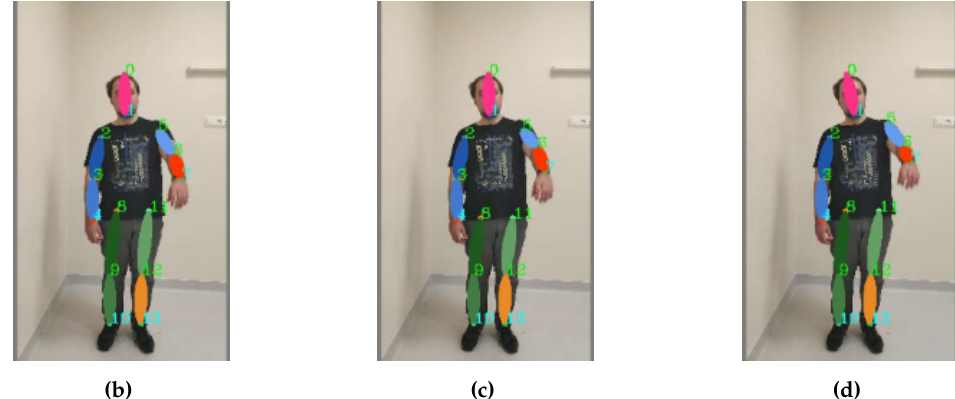
Figure 14. Arm bending with compensation from the torso: the motion sequence ( a – d ) starts on the left and ends on the right.